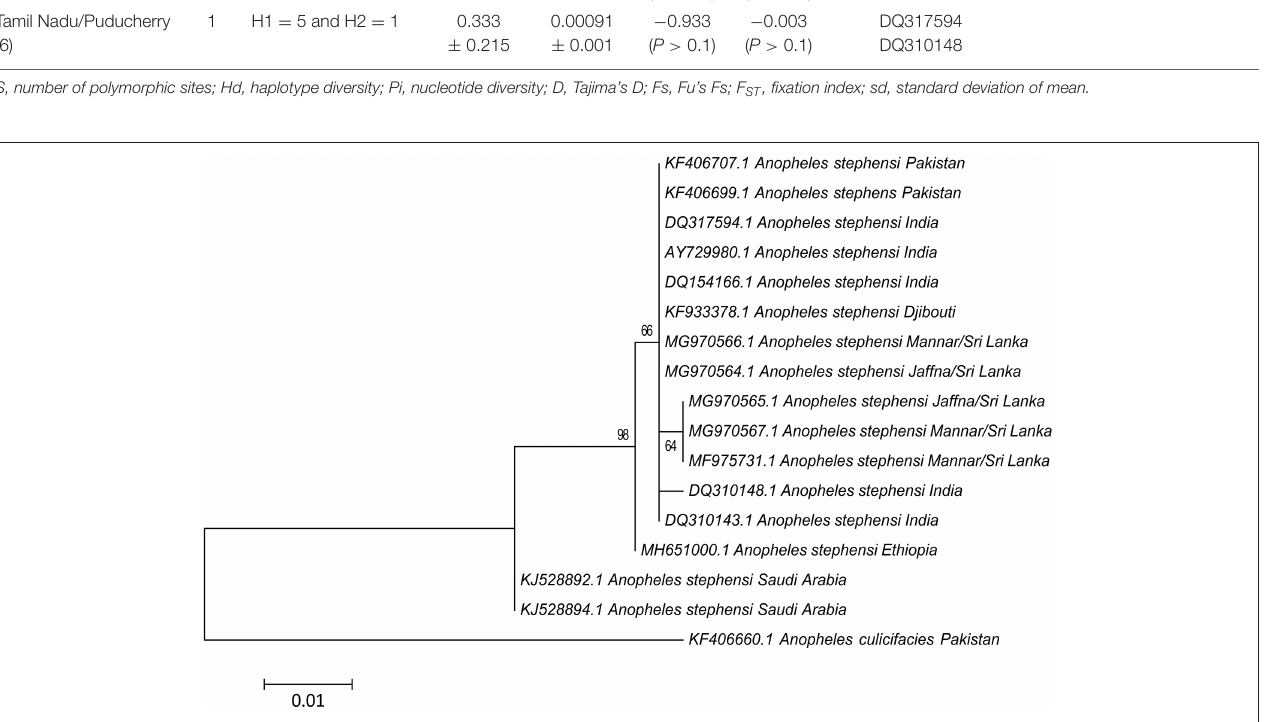
water of up to 3.5 ppt salt in Jaffna and 0.7 ppt salt in